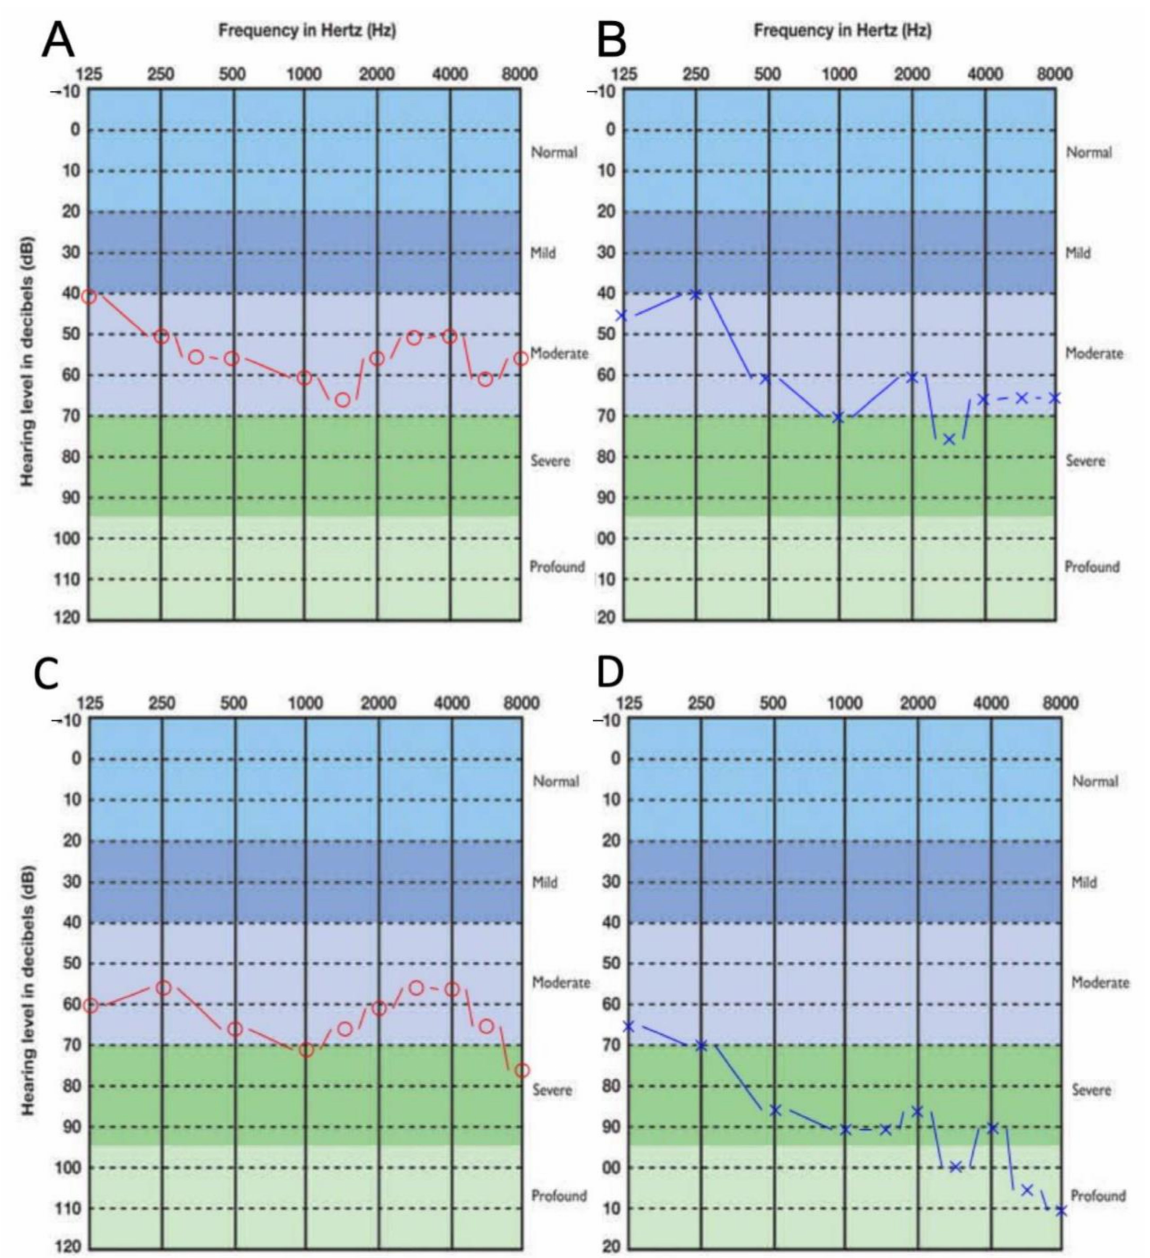
Figure 2. Pure-tone audiogram data of the mother at first admittance ( A, right ear; B, left ear) and after 14 years, at age 53 years ( C , right ear; D , left ear;). Red and blue lines depict air conduction hearing